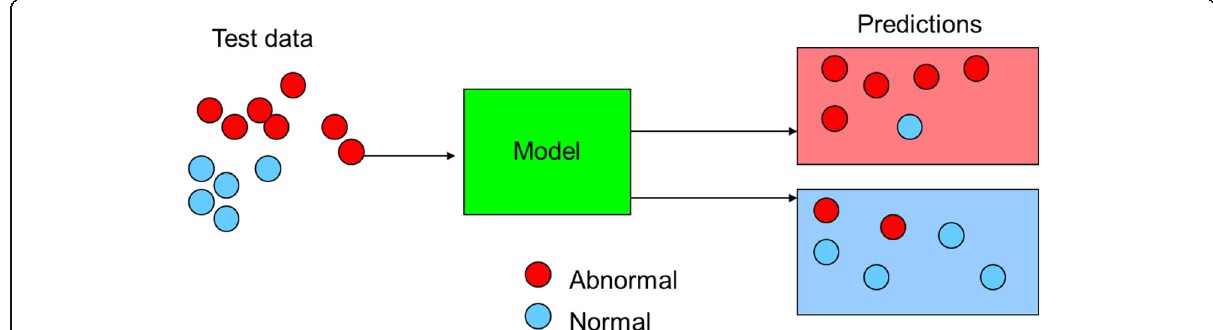
Fig. 6 A model of class attributes in fault detection